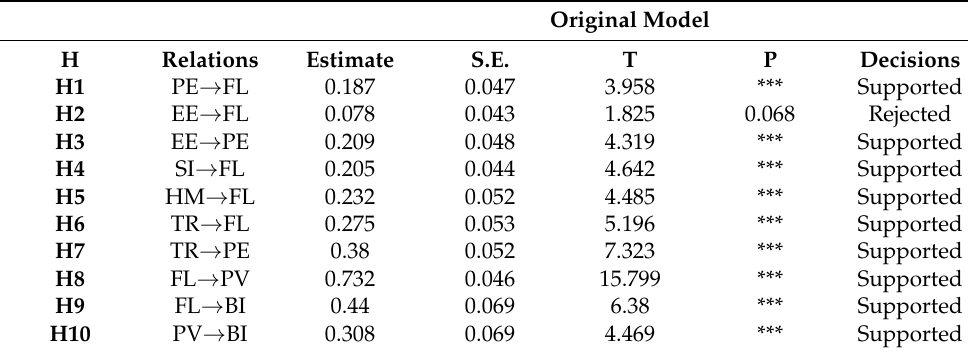
Table 7. Hypotheses testing of the original structural